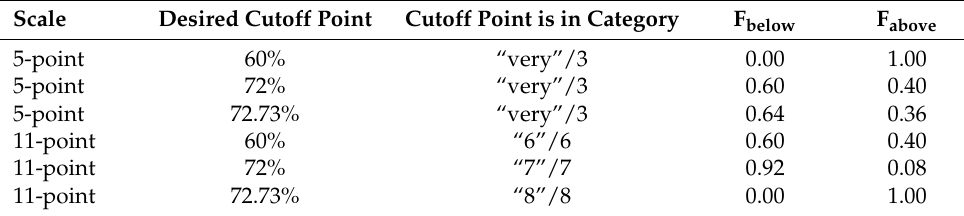
Table 3. F below and F above for different scales and cutoff points for a uniform and expectation-free distribution of the annoyance score (annoyance intensity) value within the respective category.